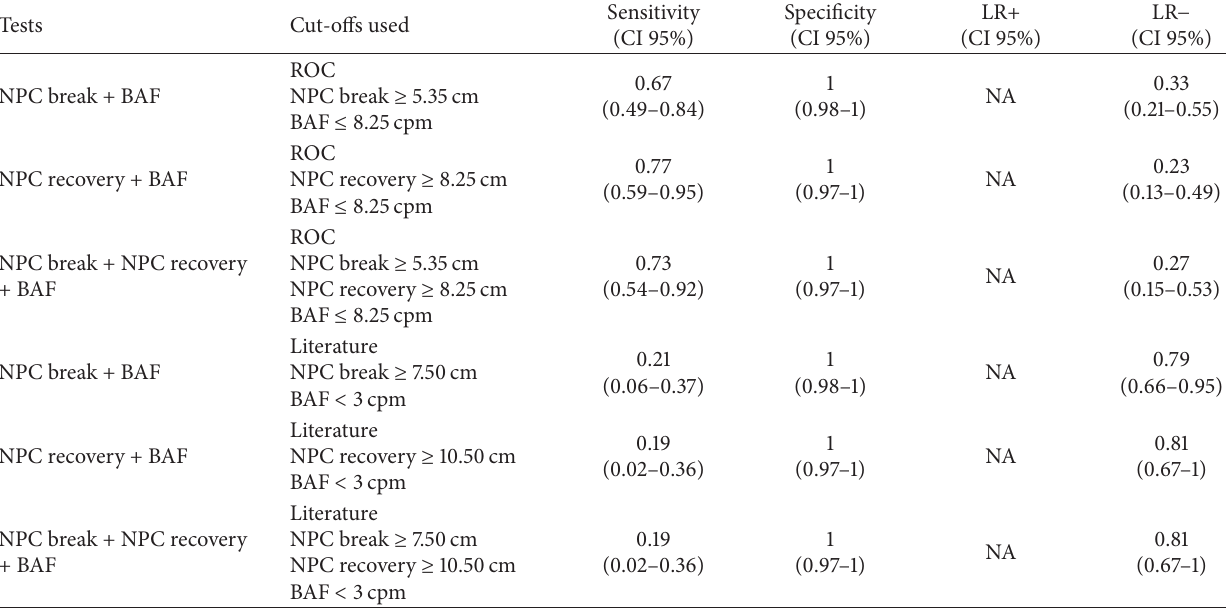
Table 6: Diagnostic validity considering multiple tests as serial testing strategy using cut-offs derived from ROC analysis and scientific